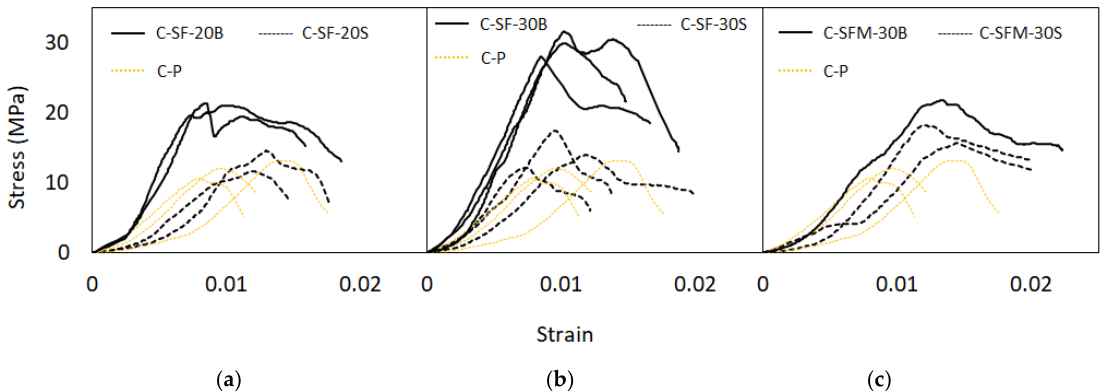
Figure 4. Implementation of strengthened masonry prisms: ( a ) Wetting bare prisms; ( b ) Plastering plain mortar primer; ( c ) Roughening the plain mortar primer using wire brush; ( d ) Plastering AS- FRM on the mortar primer; ( e ) Implementing additional mesh by plastering ASFRM; ( f ) Masonry prisms with shear connectors after the primary plastering of ASFRM.